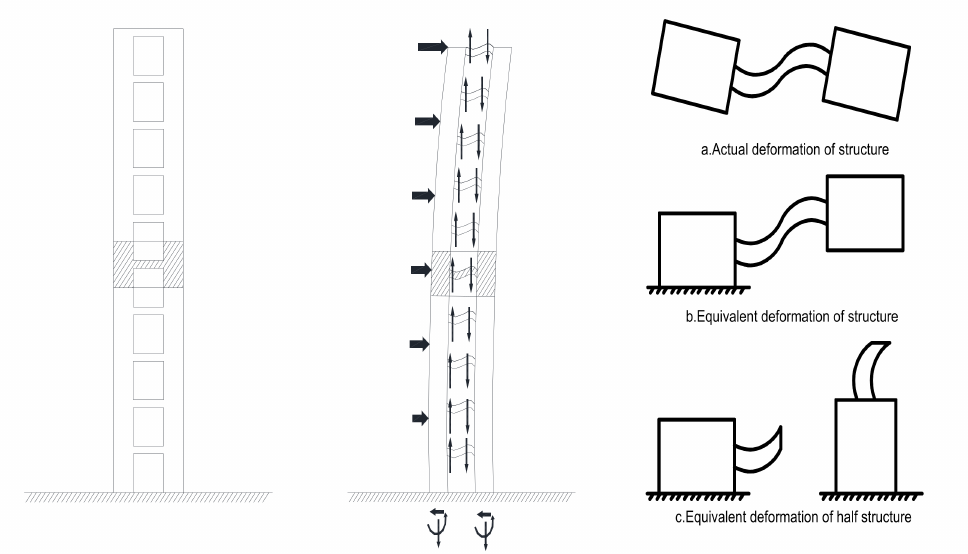
Figure 5. Equivalent deformation diagram of coupled shear wall.